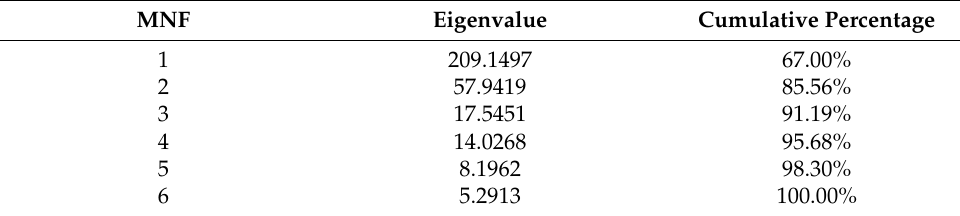
Table 2. Eigenvalues and specific gravity of each MNF component.